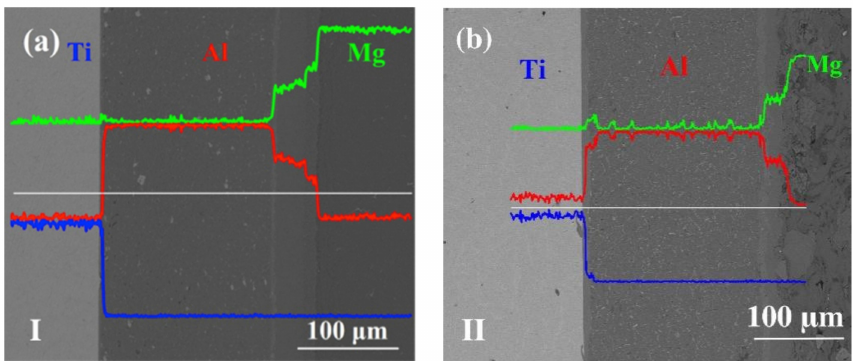
Figure 1. SEM micrographs at the interface of Ti / Al / Mg density-graded materials. ( a ) bumper I; ( b ) bumper II.